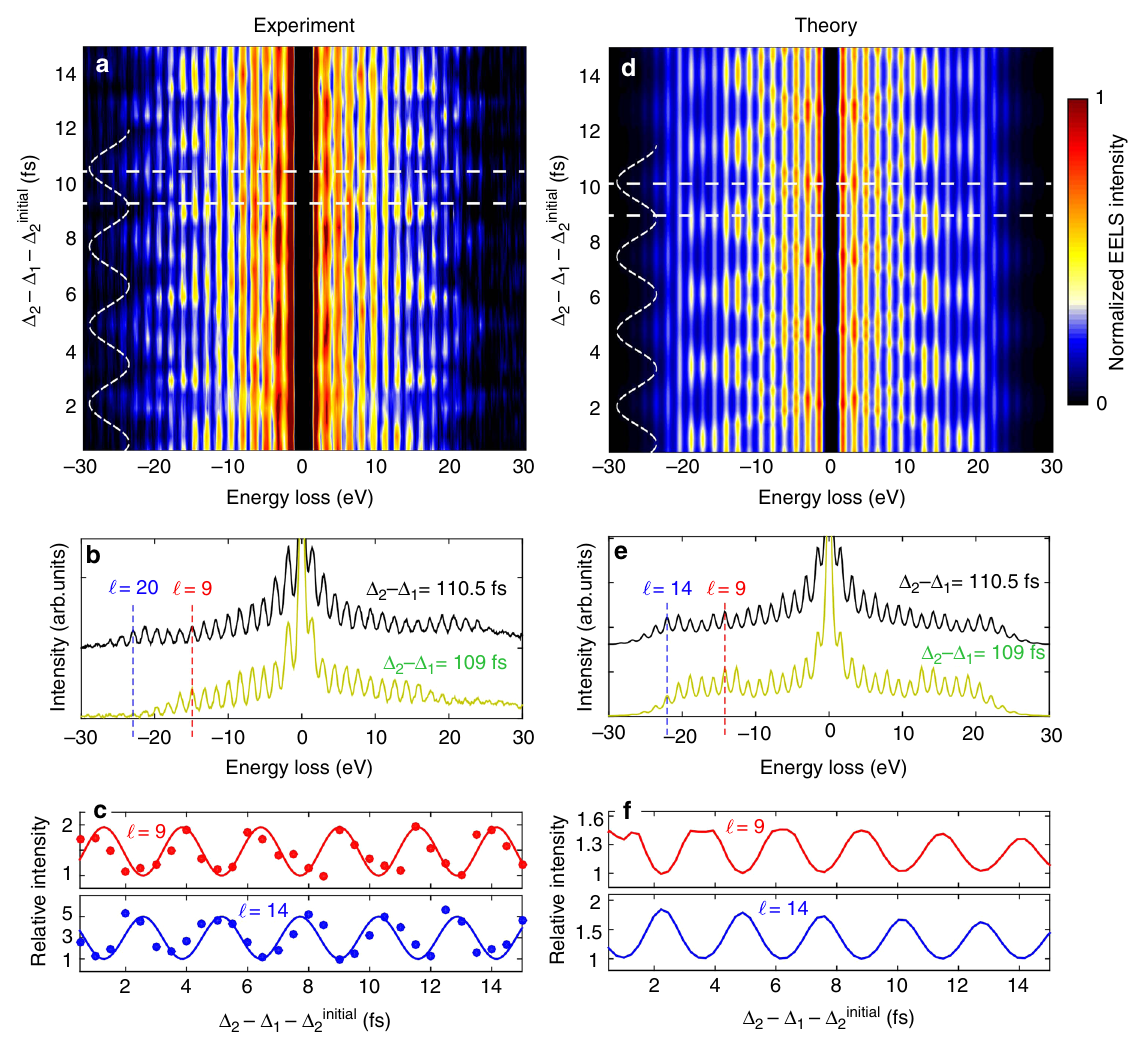
Fig. 4 Attosecond coherent control of free-electrons. The electron beam interacts with a semi-in fi nite temporally modulated optical fi eld distribution produced by a sequence of two mutually phase-locked light pulses impinging on the mirror. a Measured EELS spectra as a function of relative delay Δ 2 − Δ 1 between the two optical pulses. The tilt angles are ϑ = 35° and α = α C , the optical pulses are 60 fs long with a peak fi eld amplitude of 21.4 × 10 7 V/m each, = 100 fs. b EELS spectra taken at two different time delays (marked by horizontal dashed lines and the delays are Δ 1 = 0 and Δ 2 ≈ 100 – 115 fs, with Δ initial 2 in a ). c Relative intensity (full circles) of the ‘ ¼ 9 and ‘ ¼ 14 sidebands plotted as a function of time delay between the two optical pulses, exhibiting a periodic modulation of period ≈ 2.6 fs (equal to the optical cycle 2 π / ω ) and a relative π phase shift. Solid curves are least-square fi ts to the data. d – f Simulated EELS spectra and resulting intensity change corresponding to the experimental conditions of a – c (see Methods for details of